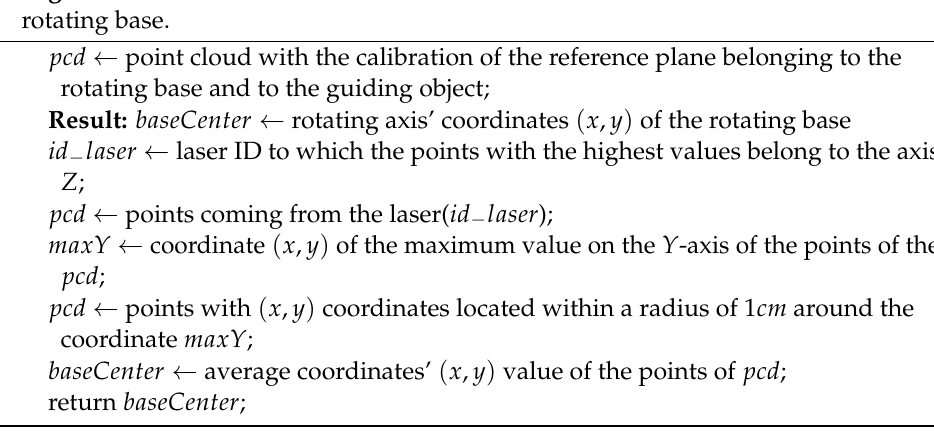
Figure 13. Result of the estimation of vegetative indexes in the Guayacan plant.